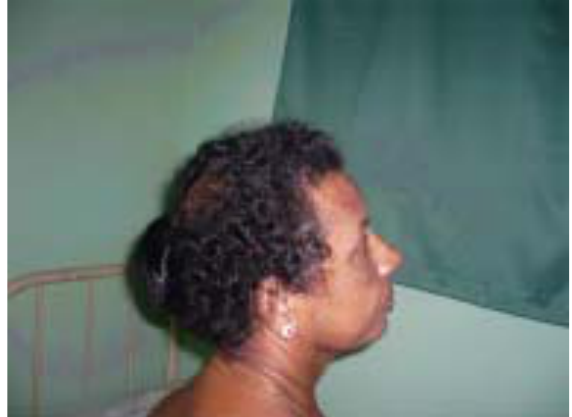
Figure 1. Figure shows the hair loss from forehead and central region of